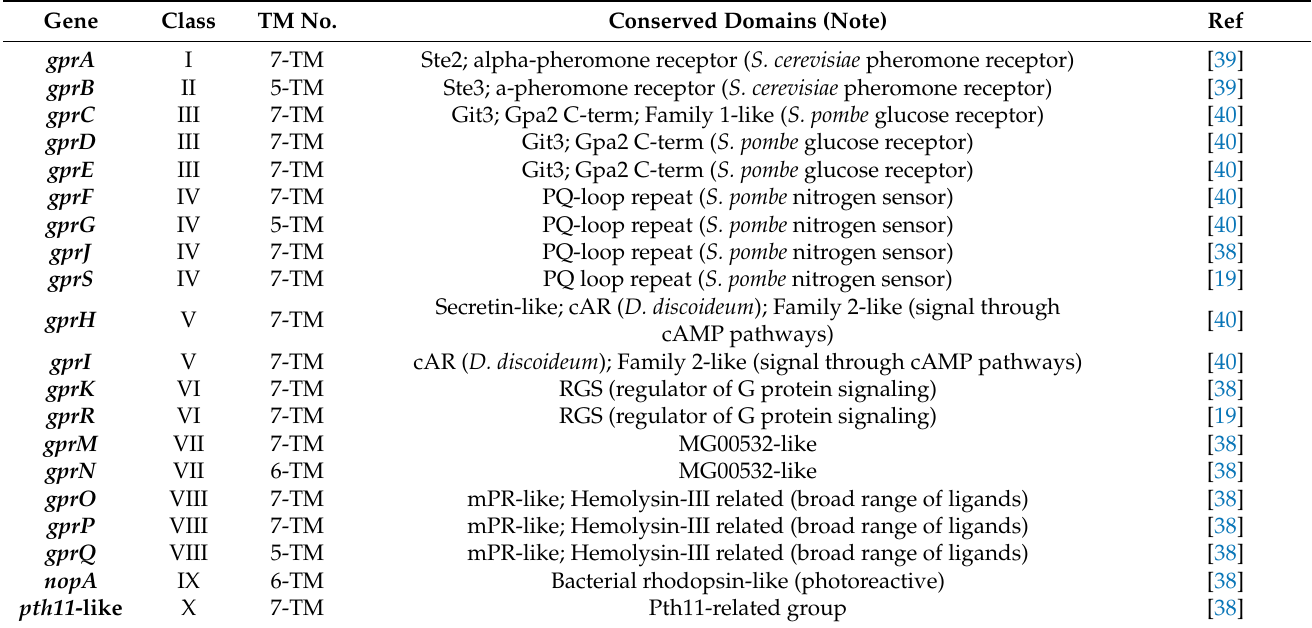
Table 1. G protein-coupled receptors in Aspergillus